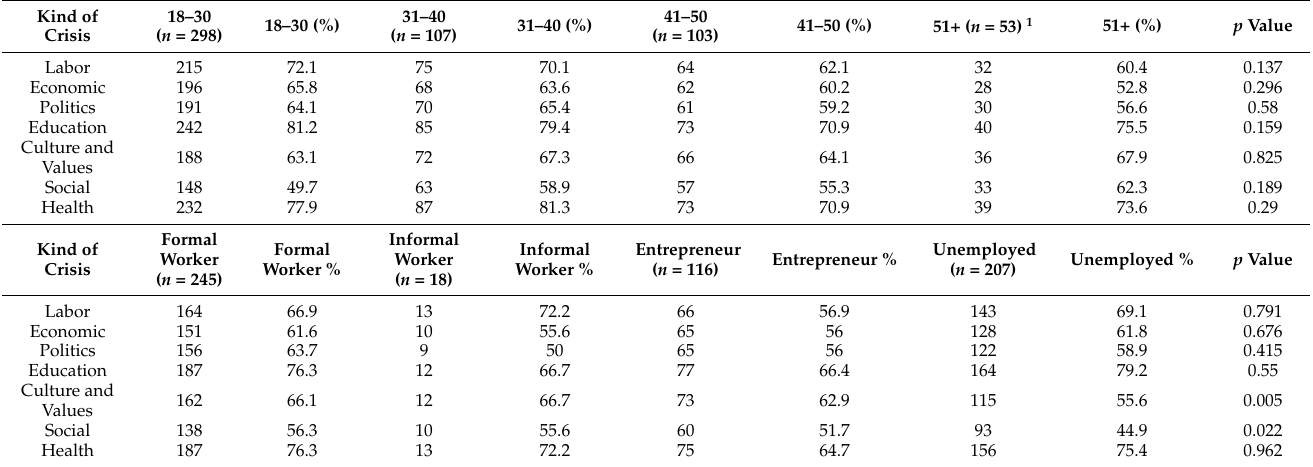
Table 3. Distribution of the sample by age group and work status according to type of crisis.